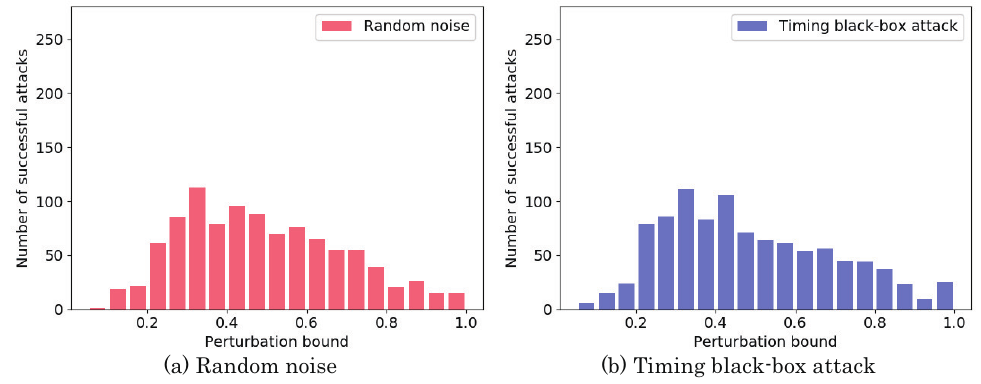
Figure 20: Histogram of successful attacks against Coral Edge TPU on 1,000 samples of MNIST dataset. Proposed attack is compared with random noise. Each perturbation bound is plotted when misclassification is caused by proposed attack and random